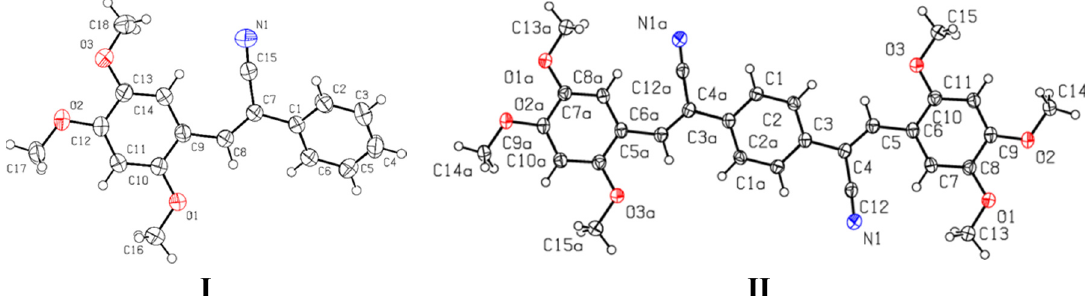
Figure 11. A view of the structures I and II , showing the atom-labelling scheme. Displacement ellipsoids are drawn at the 50% probability level.